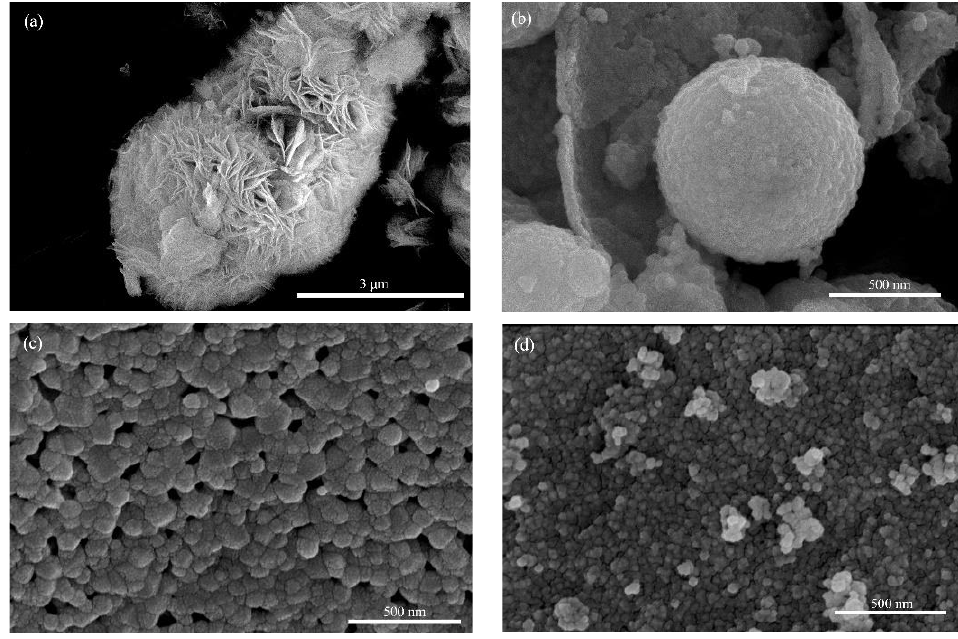
Table 1. Specific surface area and pore structure parameters of Y-ZrO 2 composite oxides with dif- ferent morphologies.